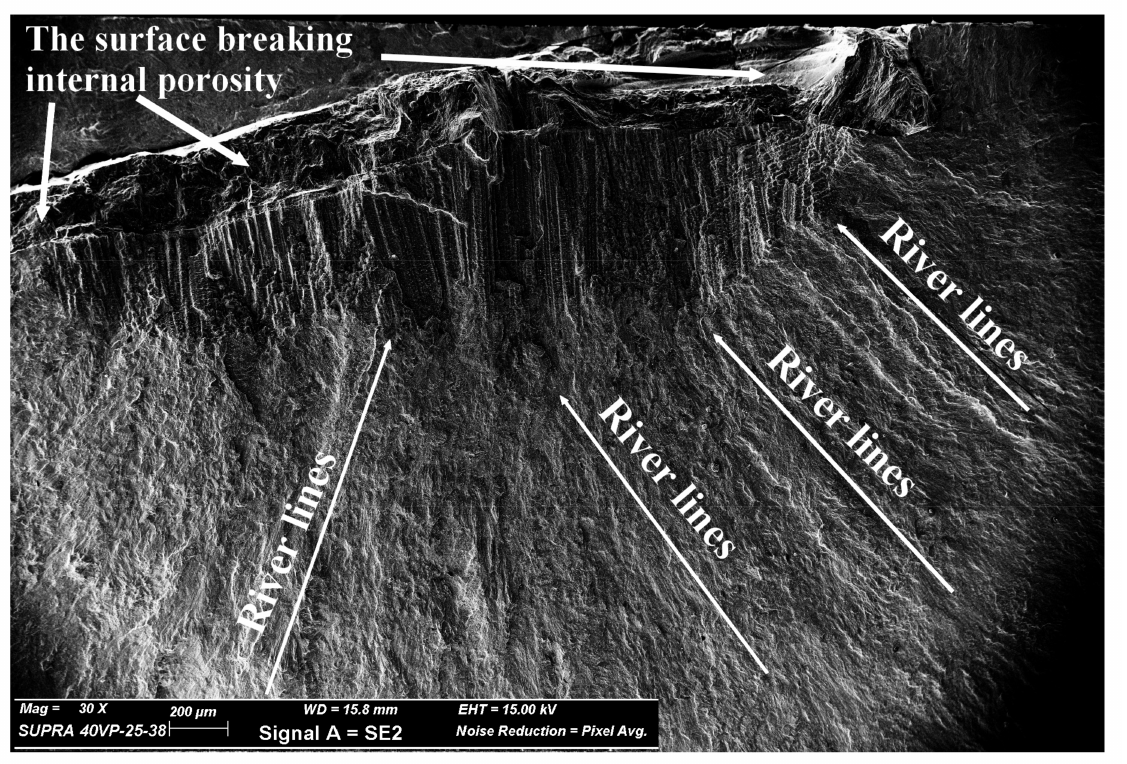
Figure 6. SEM image of the critical location showing the multiple initiation sites. Here, it should be noted that, for clarity, the image is inverted with respect to Figure 4. The scale, magnification factor, etc., are shown in the figure.